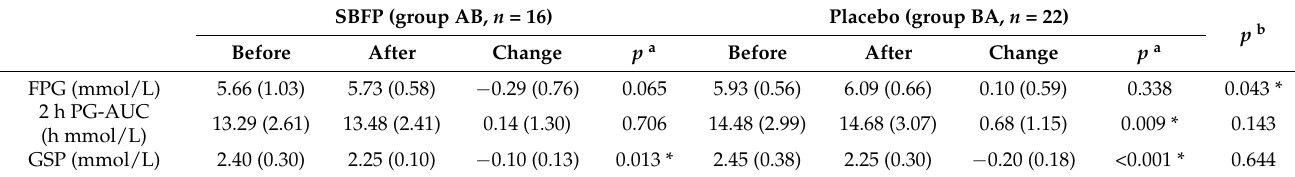
Table 7. Effects of SBFP and placebo on glycemic markers during wash-out